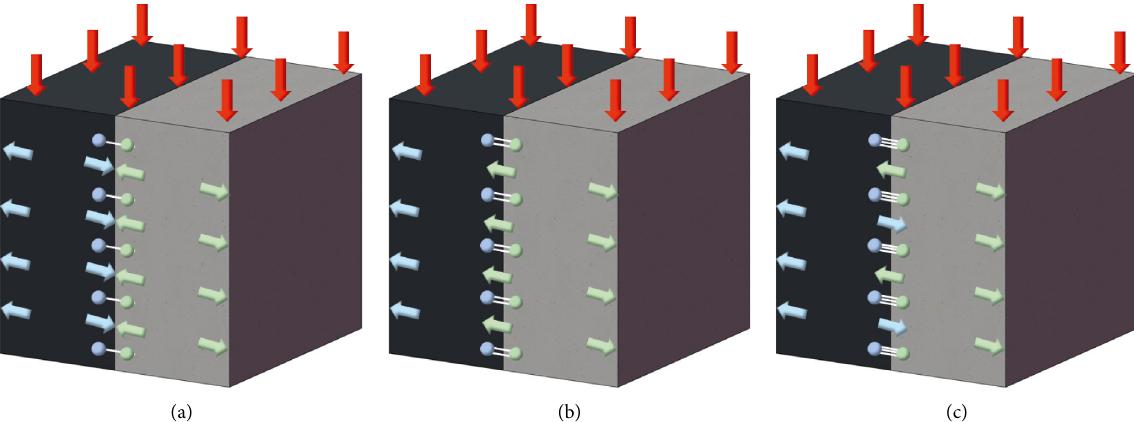
Figure 1: Stress state of coal pillar-artificial dam. (a) Split bearing, (b) shared bearing, and (c) coordinated bearing.